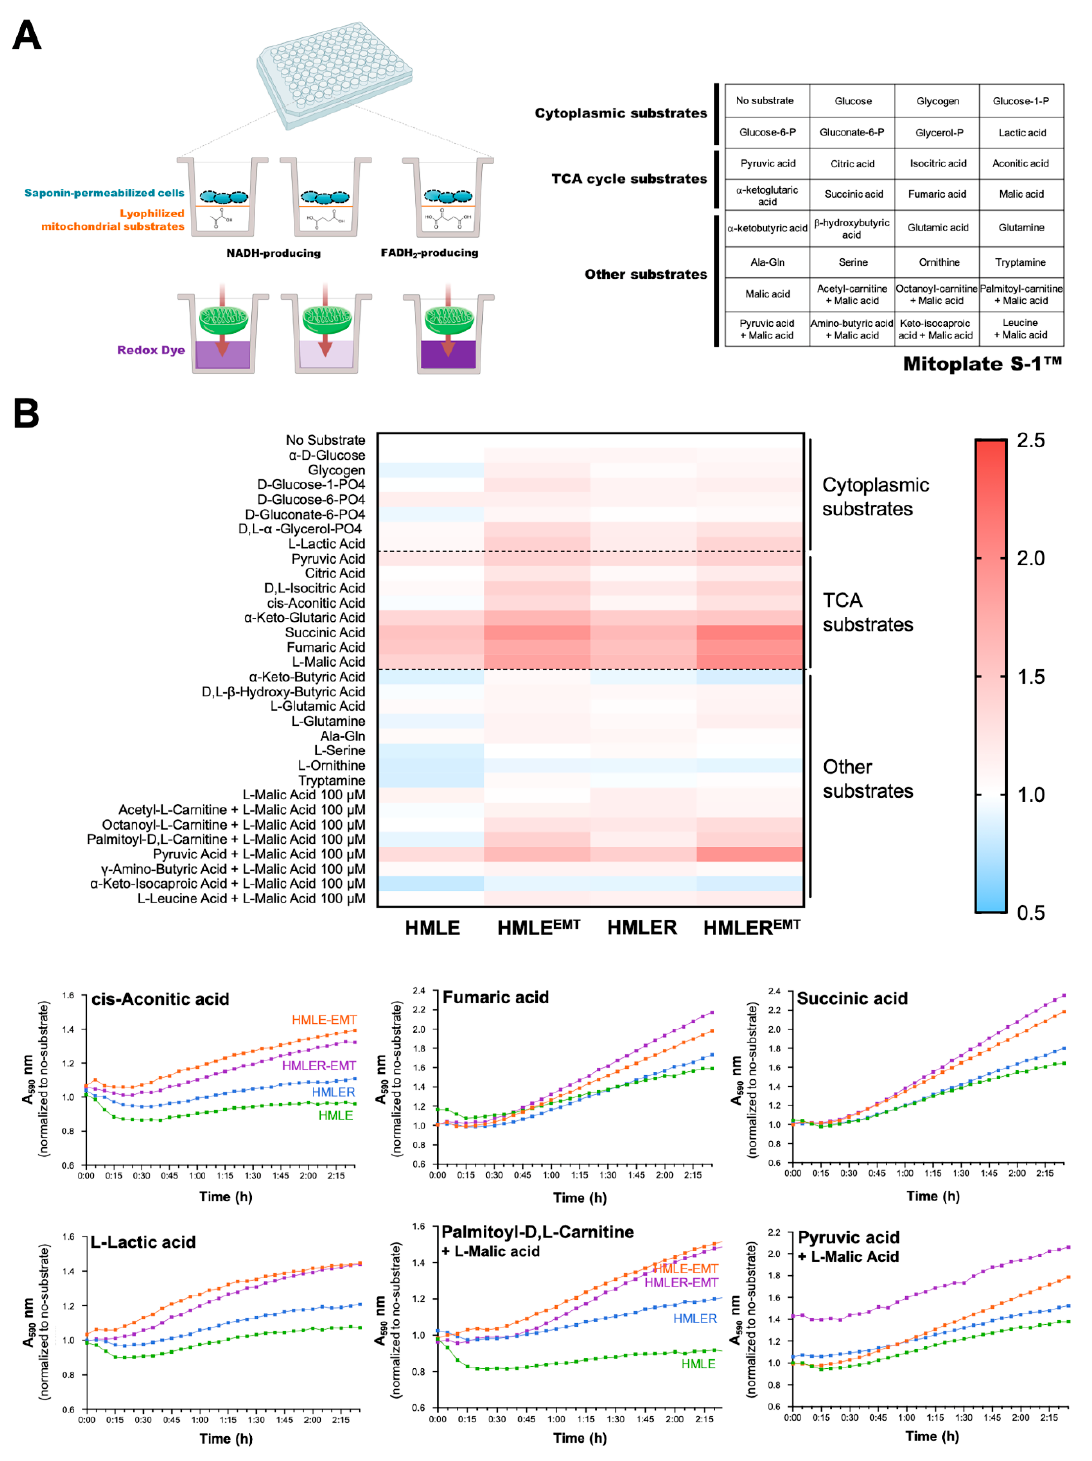
Figure 7. Mitochondrial functioning of non-tumorigenic and tumorigenic EMT. ( A ) Mitochondrial phenotyping of HMLE/HMLE-EMT and HMLER/HMLER-EMT cells using mitochondrial function assays with Biolog MitoPlate S-1 ( n = 3). ( B ) Top: Representative heatmap of the metabolic substrate consumption (2 h) of fatty acids, glycolysis, amino acids, and TCA cycle intermediates in HMLE/HMLE-EMT and HMLER/HMLER-EMT cells ( n = 3 ). Bottom: Representative reduction dynamics of the dye over time measured as absorbance at 590 nm for 2 h at 5-minute intervals ( n = 3 ).